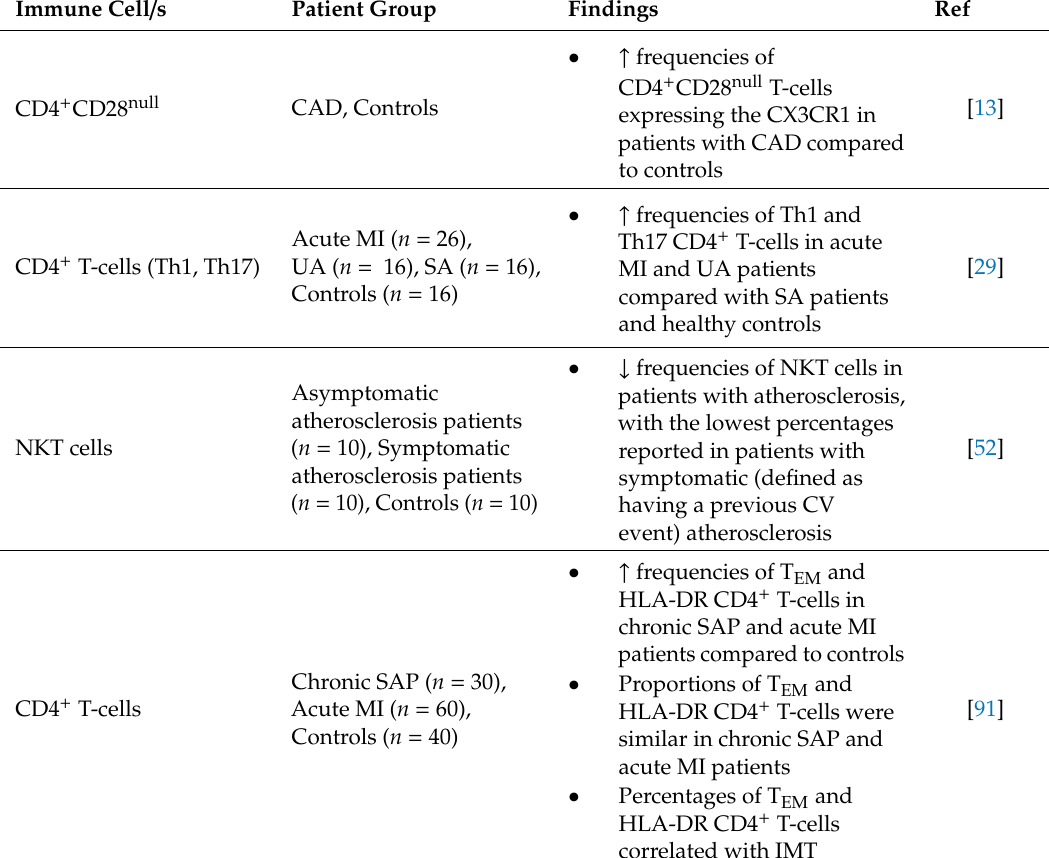
Table 1. Clinical utility of profiling circulating cells of the adaptive immune system to monitor atherosclerosis